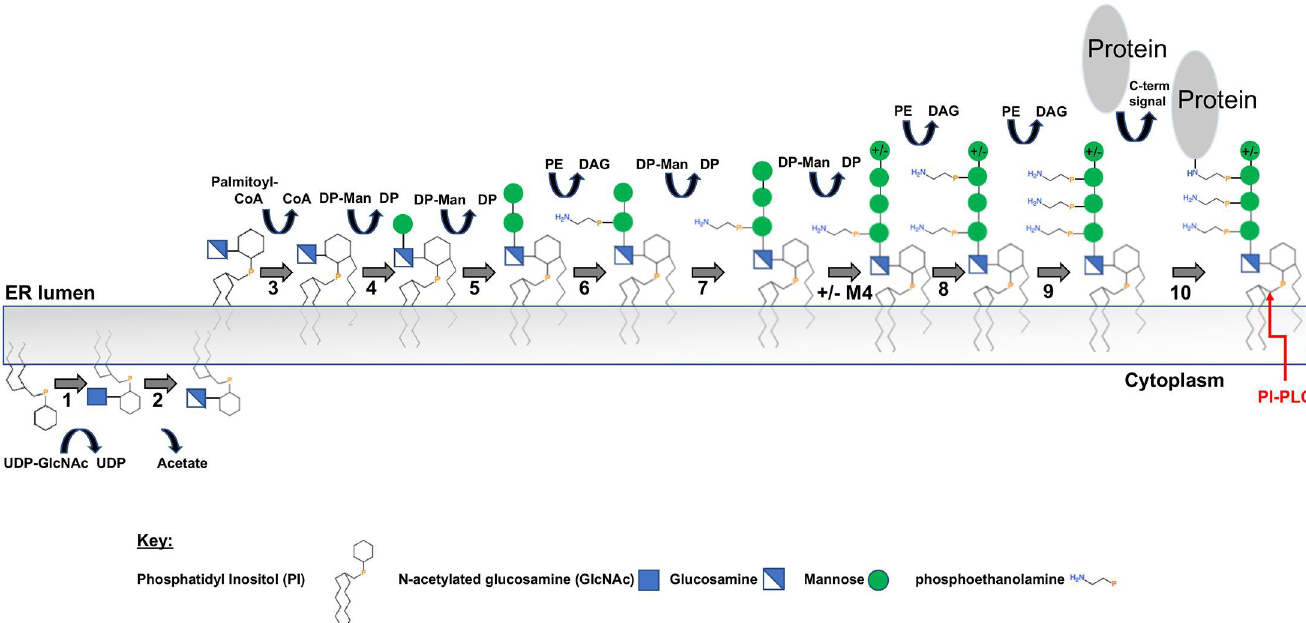
Fig 1. The conserved steps in the GPI-AP synthesis pathway. The enzymes or enzyme complexes for each step are listed in Table 1. UDP-GlcNAc: UDP-N- acetylglucosamine; DP-Man: Dolichol-P-Mannose; PE: Phosphatidylethanolamine; DAG: diacylglycerol. The phosphatidylinositol-specific phospholipase C (PI-PLC) cleavage site to release glycosylated protein is noted on the final